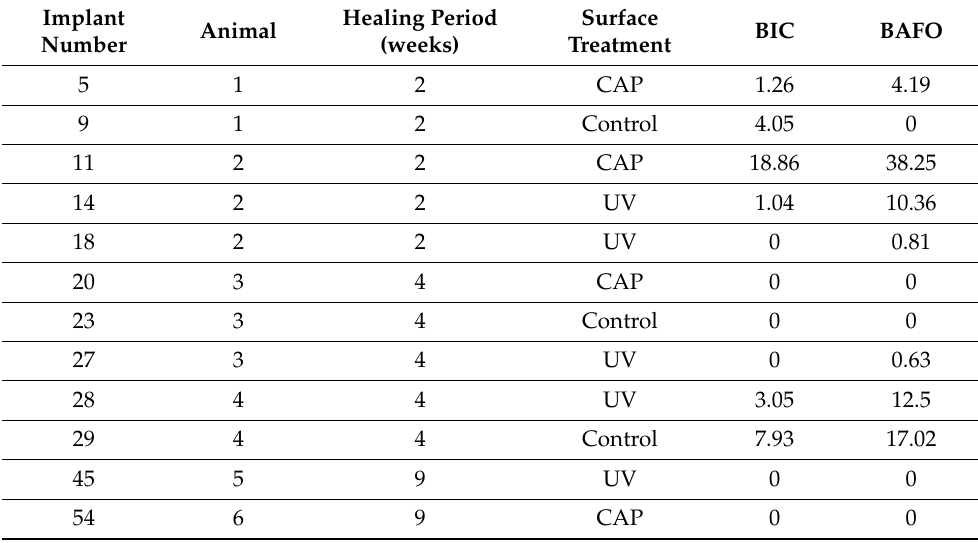
Table 5. Characterization of non-osseointegrated implants during the different healing times. Healing Period Implant Animal (weeks) Number